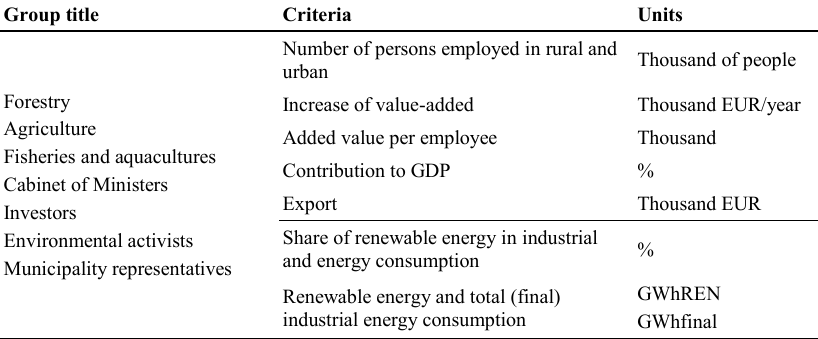
Fig. 1. Integration of role game in the modular structure of bioeconomy awareness building. T ABLE 1. M AIN P ROPOSAL E VALUATION C RITERIA FOR G